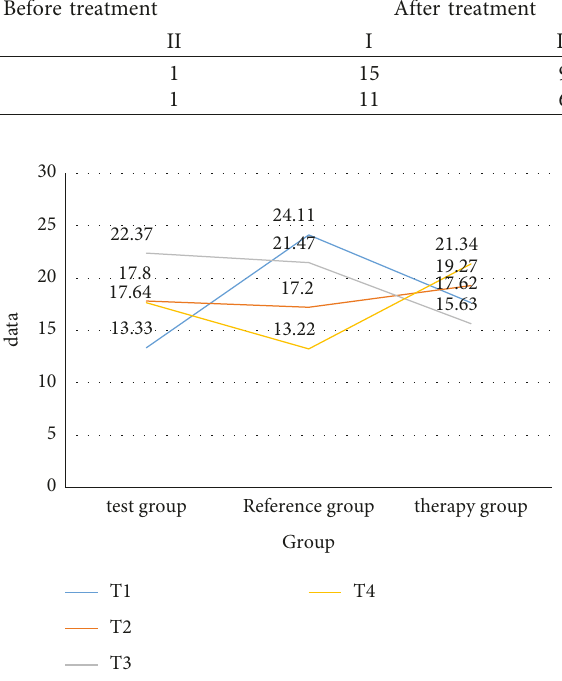
Figure 5: FDIP evaluation of the two groups at the four time nodes of T1, T2, T3, and